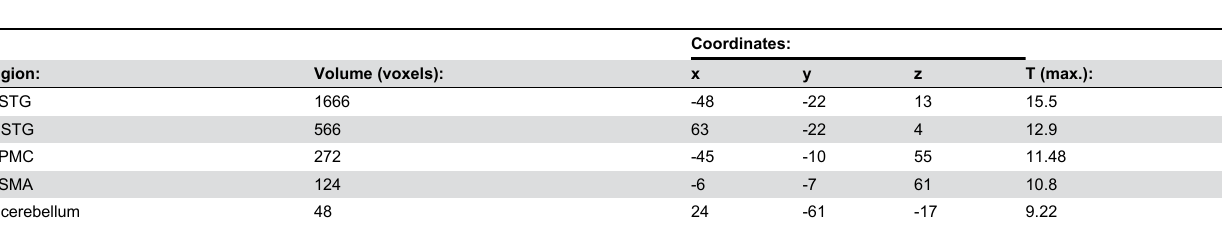
Table 2. Peak neuronal responses in the whole brain analysis during auditory-paced finger tapping task, averaged across all experimental